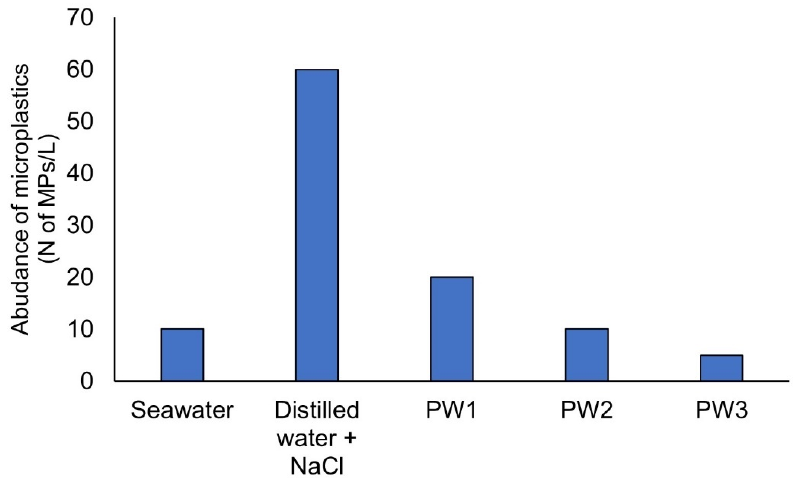
Figure 5. Abundance of microplastic (number of MPs/L) in different water samples: seawater, distilled water + NaCl, purged water every 3 h (PW1, PW2, PW3). Only blue-colored fibers were found in the seawater and in the purged water after 9 h, and blue and black fibers were found in purged water after 6 h, while in the water with NaCl and in the purged water after 3 h, the variability of the colors was greater (Figure 6). Regarding size, the range in water samples was 0.1–1 and 1.1–2 mm, while no MPs in the range 2–3 mm found in wedge clams were observed (Figure 7). Only MPs in the range 0.1–1 mm were found in the sample of purged water after 6 h, while in the sample of purged water after 9 h, the size varied between 1 and 2